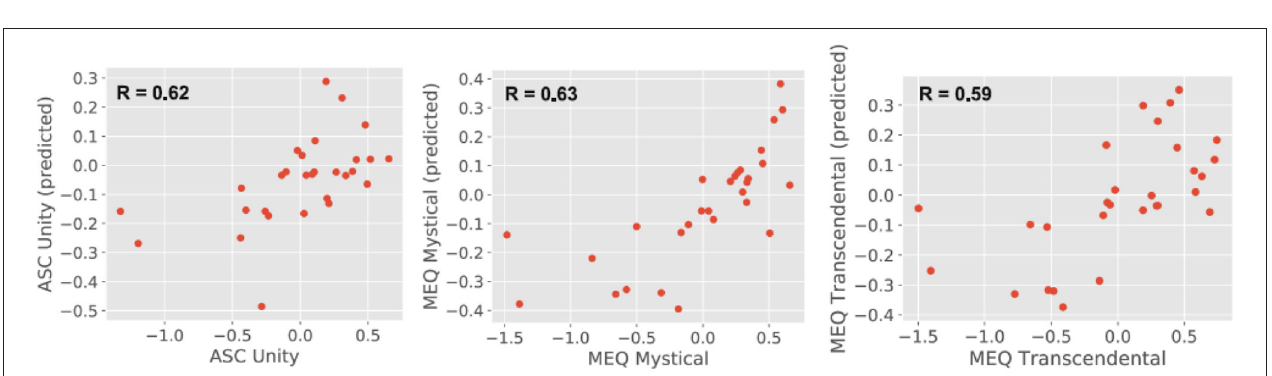
FIGURE 4 | Predicted (random forest regression model) vs. actual questionnaire subscale values (in both cases standardized to z-scores) with the linear correlation coefficient between both included as an inset.